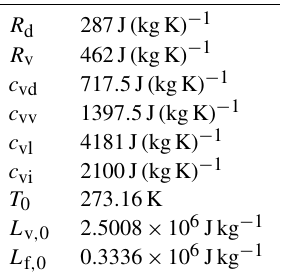
Table 1. Thermodynamic constants in